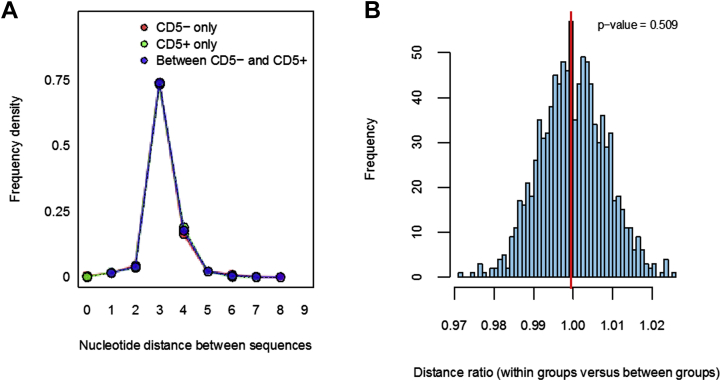
Testing the sub-clustering of CD5high and CD5low BCR sequences in the CLL BCR sequences in CLL patient 4. (A) Histogram of the nucleotide distances between any two sequences within the CD5low (red) or CD5high (green) or between the sequences of the CD5high and CD5low subsets (blue). The three subsets showed indistinguishable distributions of nucleotide distance distributions suggesting that the CD5high and CD5low CLL B cells are co-clustered. (B) To determine whether the CD5low and CD5high sequences subcluster into distinct groups on the phylogenetic tree (where the null hypothesis is that they are randomly distributed on the phylogenetic tree), the distances were randomly sampled at the same proportions, and the histogram of distance ratios of within groups versus between groups was calculated for each iteration. The p value for which the observed data distance ratio was nonrandom is not significant (bootstrapped p = 0.509), suggesting that the null hypothesis should be accepted and the sequences that generate the pairwise distances are randomly distributed on the tree (i.e., there is no parsimonious route to a single or low number of switch events).